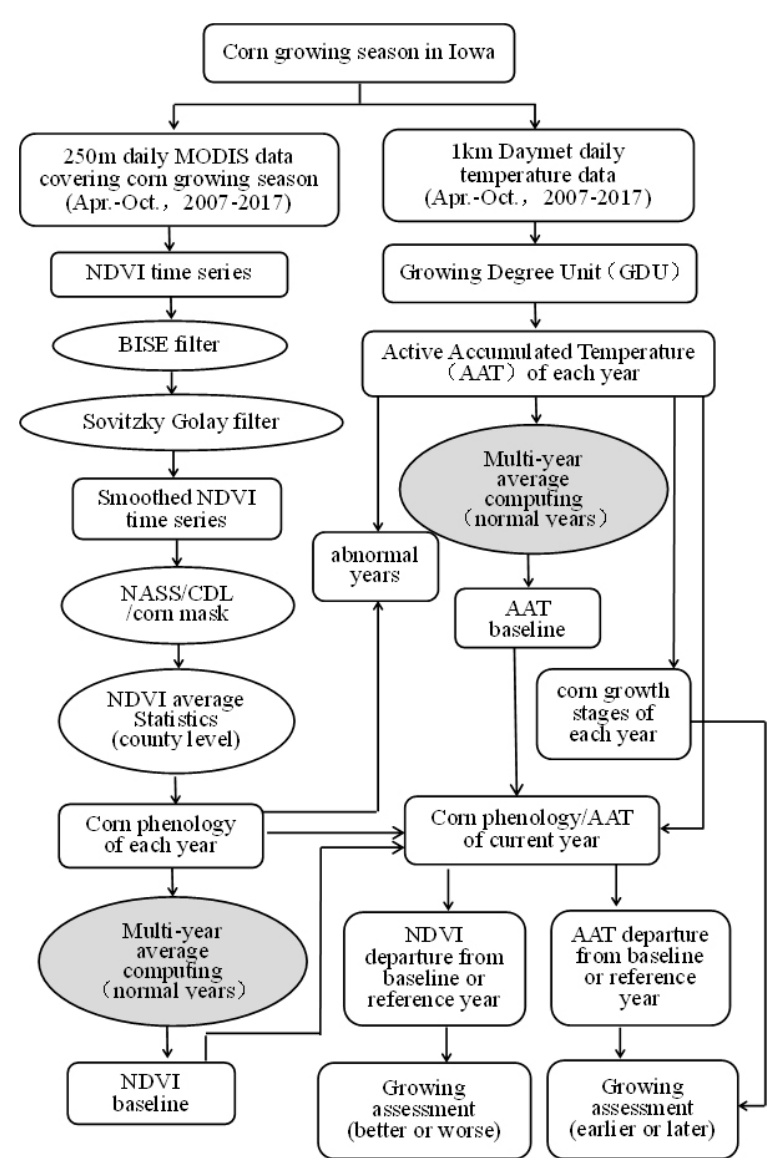
Figure 2. Flowchart of the corn growth condition assessment methodology based on heat-aligned crop growth stages. The left part shows the procedures for producing noise-filtered NDVI time series data; the right part illustrates the procedures for computing active accumulated temperature (AAT), estimating corn growth stage and assessing crop growth conditions based on aligned crop growth stages.